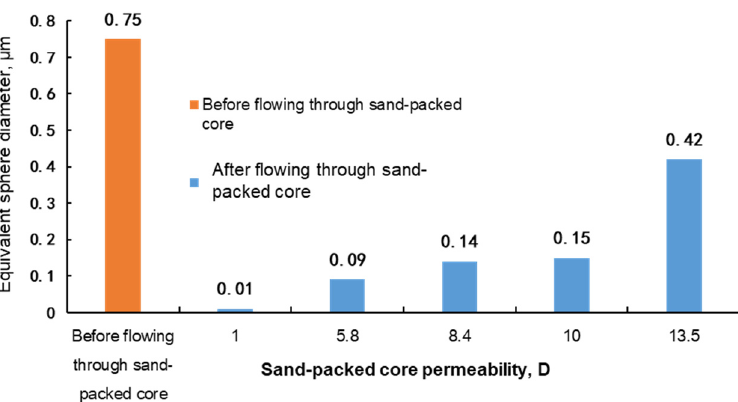
Figure 3. Measurement of equivalent sphere diameter of phenolic gel before and after flowing through sand-packed cores.